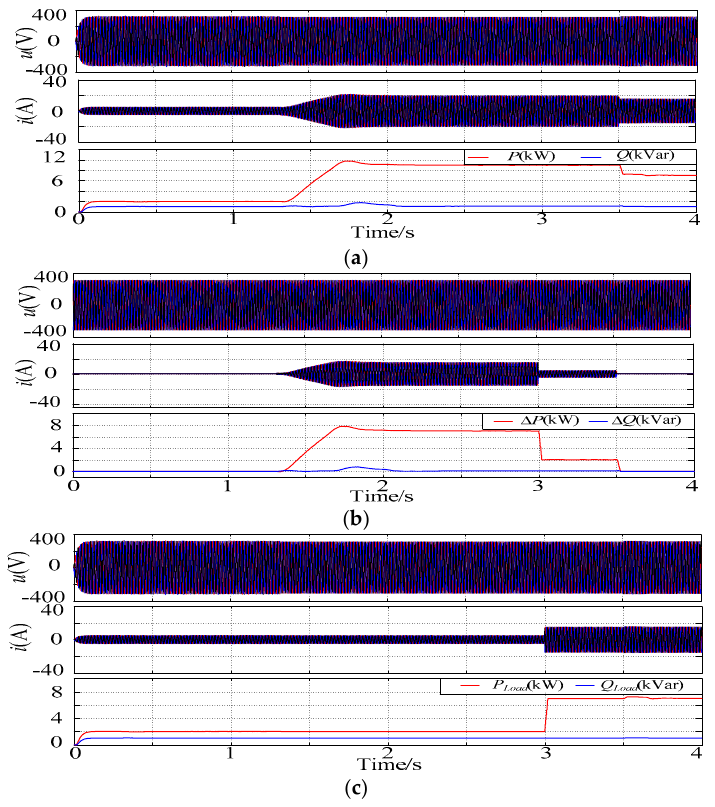
Figure 17. Seamless transform between OGM and GCM: ( a ) The voltage, current and power of the inverter output; ( b ) The voltage, current and power of the grid; ( c ) The voltage, current and power of the loads.